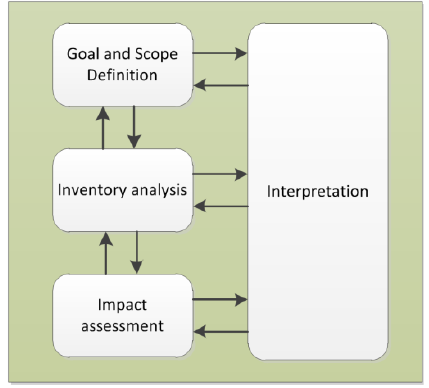
Figure 1. LCA framework adapted from ISO